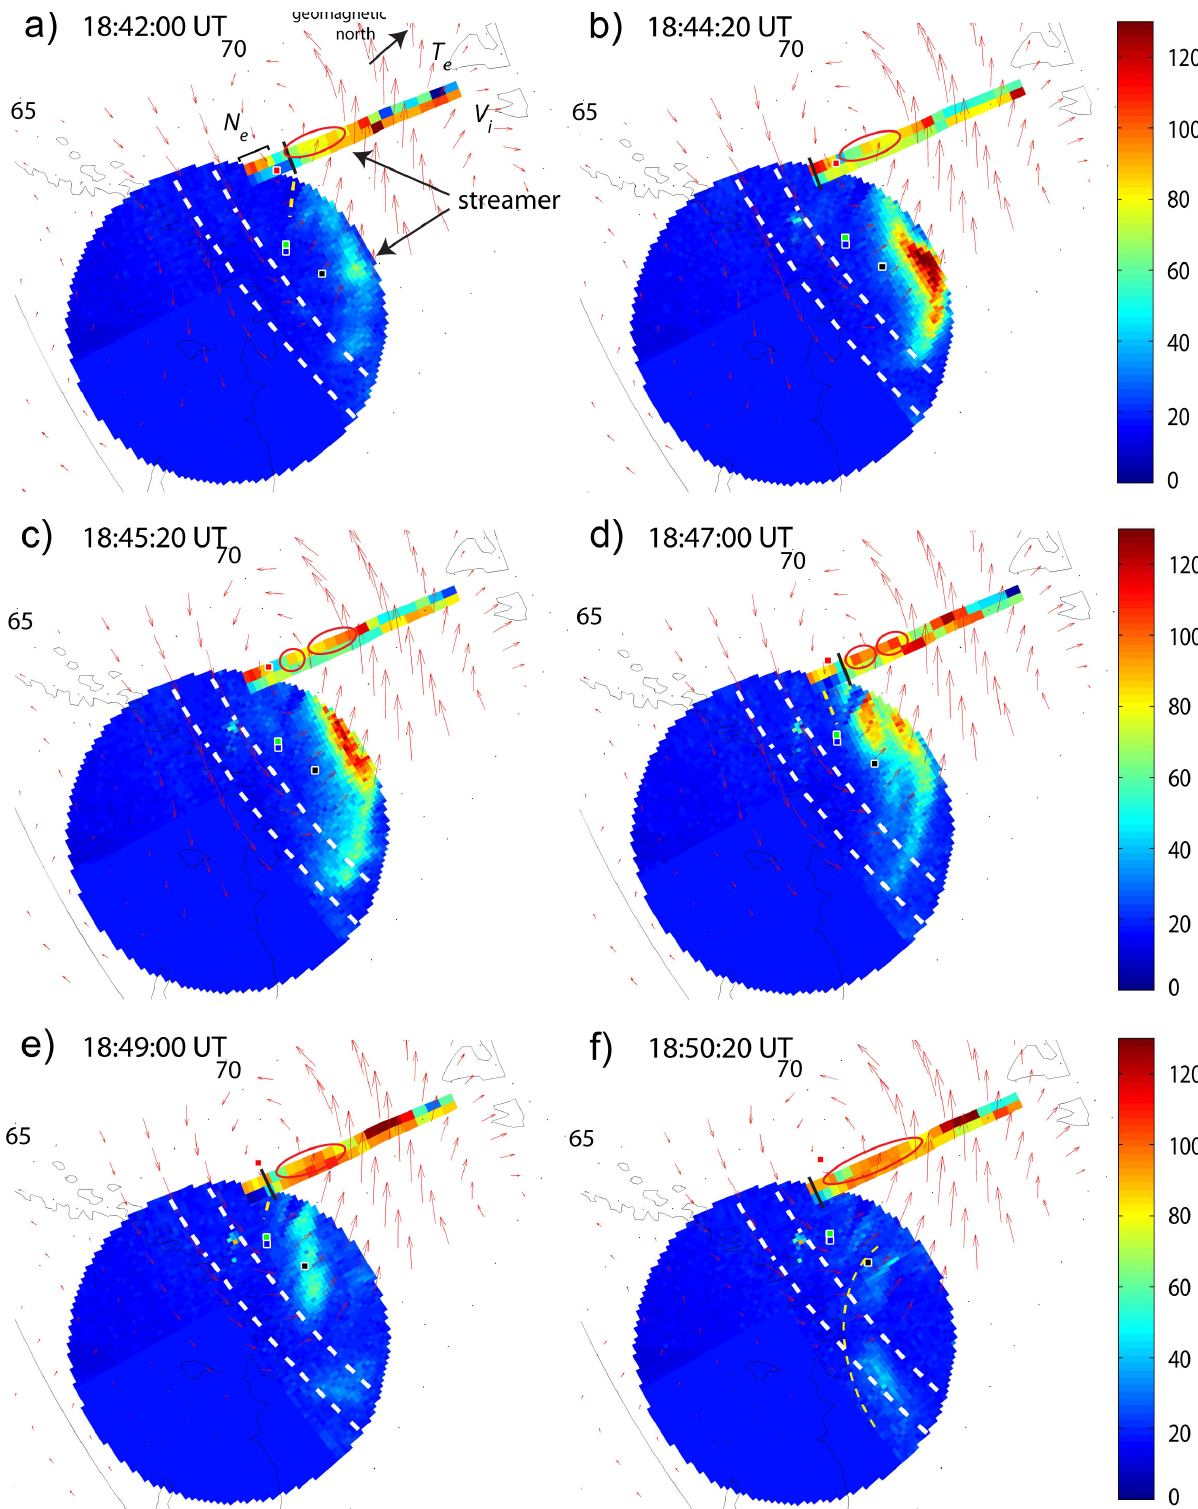
Fig. 10. Same as Fig. 8, but for BBF flow event 3. See the other details in the